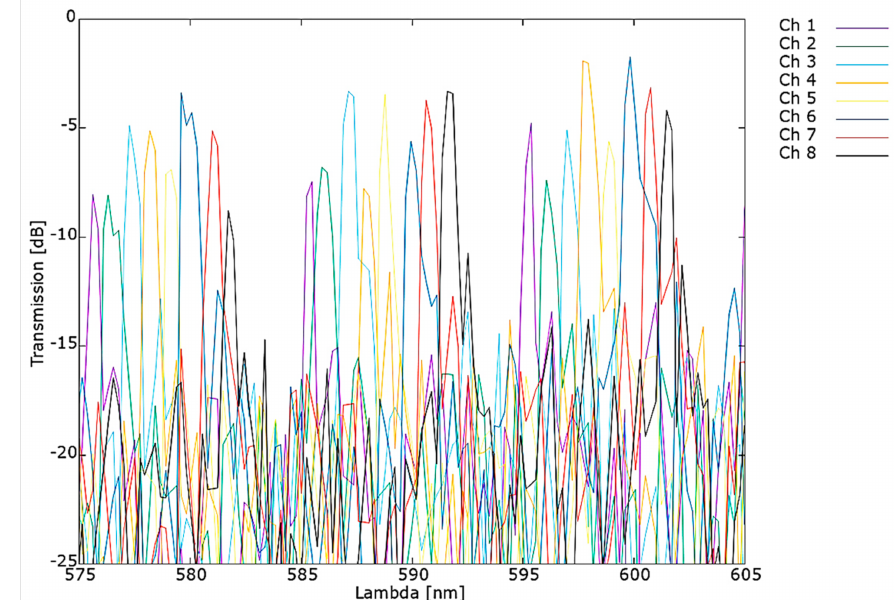
Figure 24. Measured spectrum of AWG 1 × 8 optimized for 590 nm